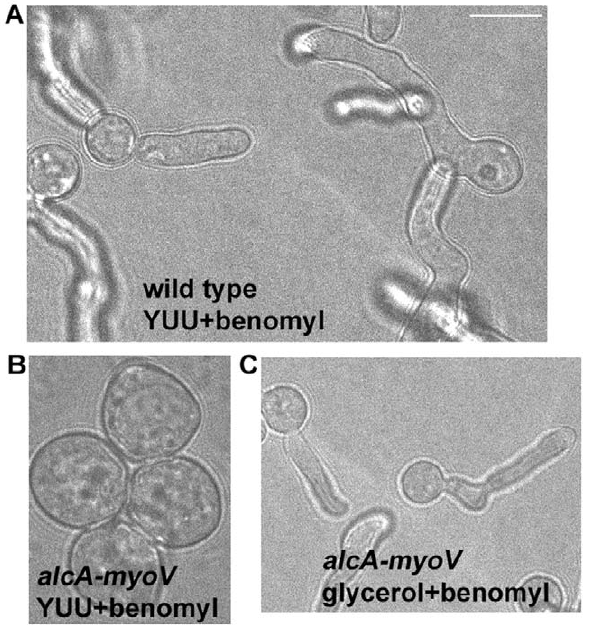
Figure 4. The alcA-myoV mutant loses polarity in the presence of benomyl when grown on repressive YUU medium. Cells were grown overnight at 32 u C in YUU medium and in the presence of 2.4 m g/ ml benomyl. Shown are a wild type strain (A) and the alcA-myoV mutant (B). The control in Panel C shows that the alcA-myoV mutant undergoes polarized growth when grown on glycerol medium in the presence of benomyl. All panels shown are at the same magnification. Bar, 5 m m.